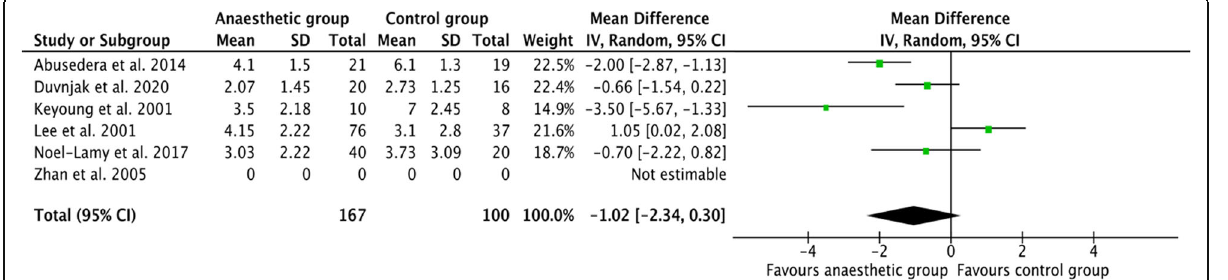
Fig. 2 A forest plot of randomised controlled trials (RCTs) summarising theeffect of intra-arterial anaesthetic on post-operative pain